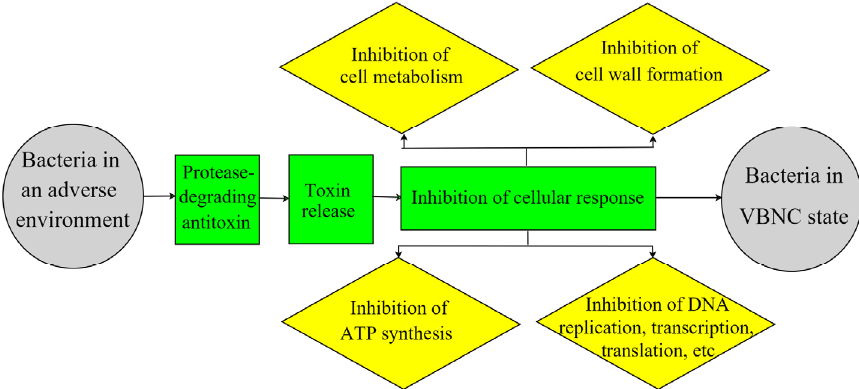
Figure 3. Schematic diagram of toxin–antitoxin (TA) system theory